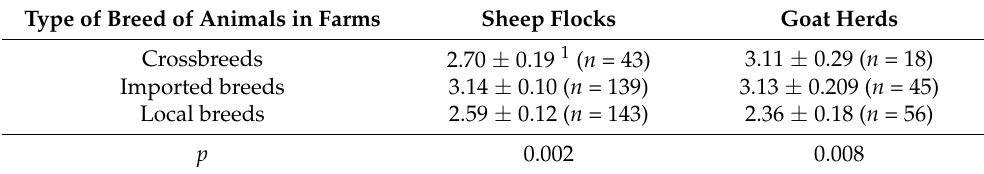
Table 6. Total number of optional vaccinations performed in 325 sheep flocks and 119 goat herds in Greece in accordance with breeds of animals in these